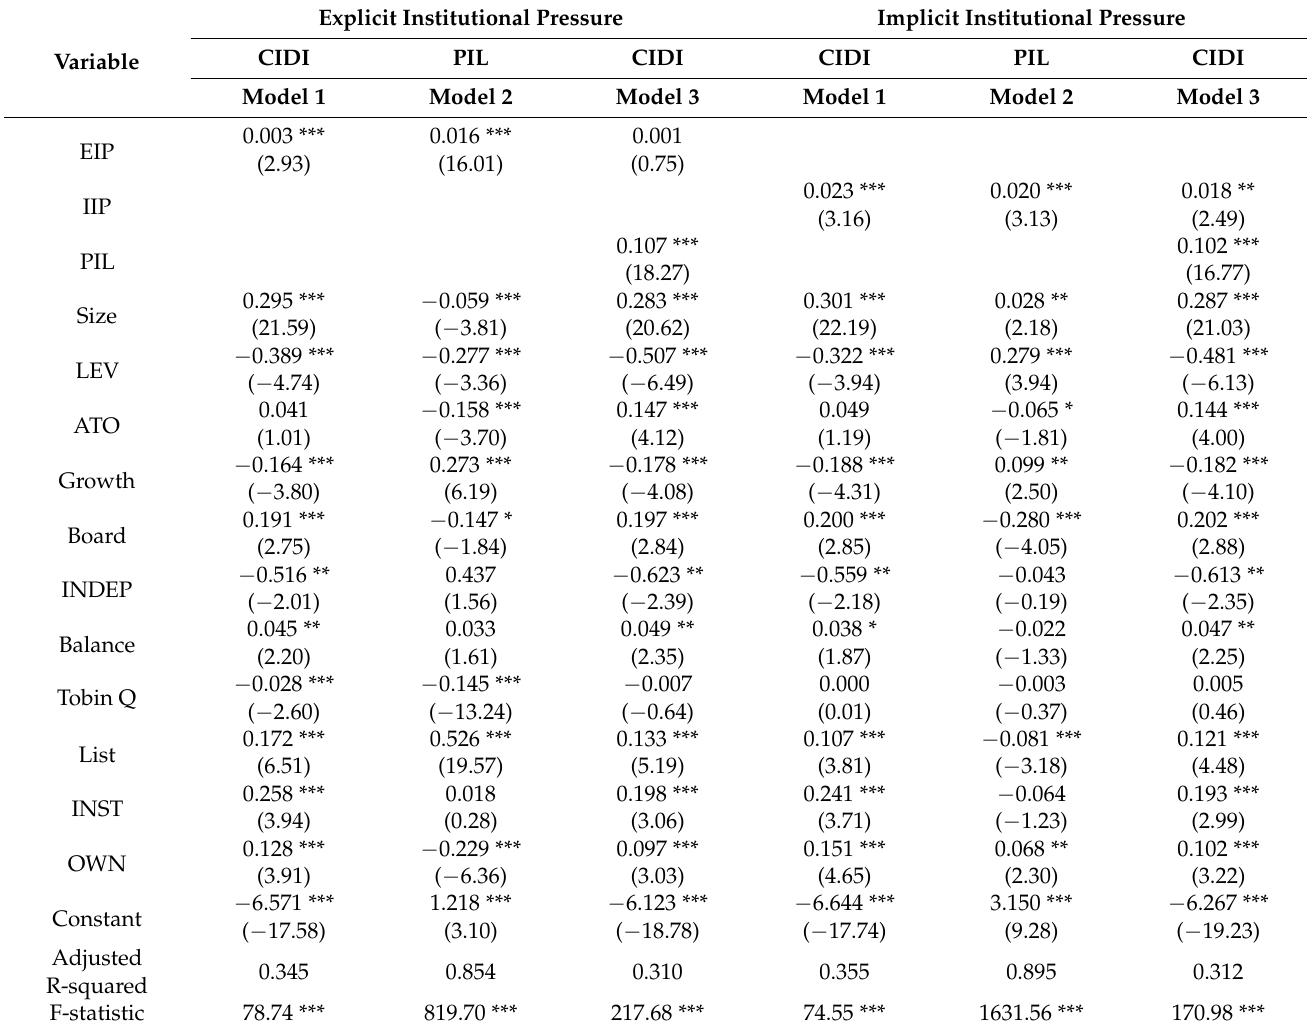
Table 6. Results of multiple linear regression